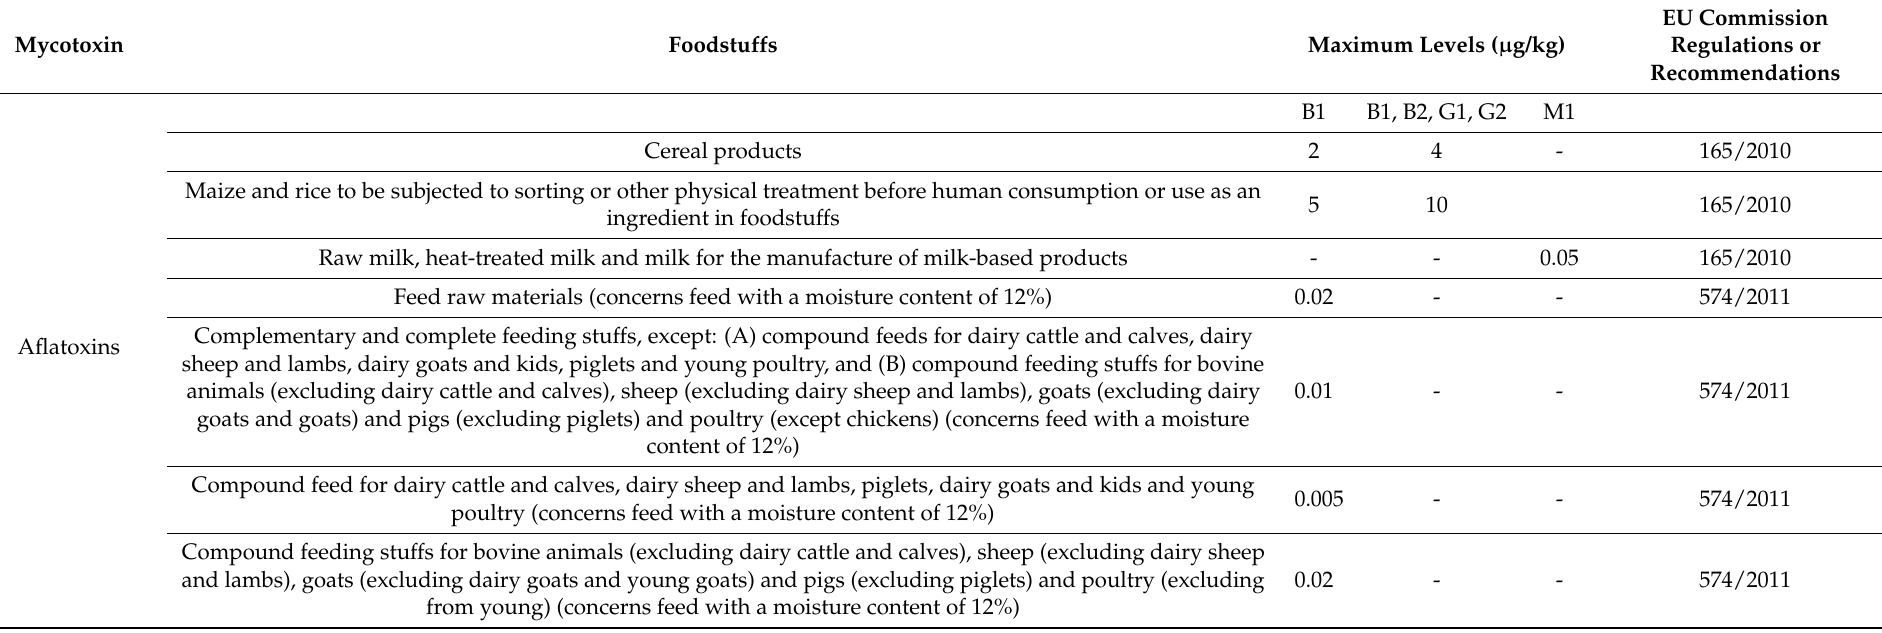
Table 2. Focus on European legislation and major regulations and recommendations regarding the maximum levels of mycotoxins in foods and